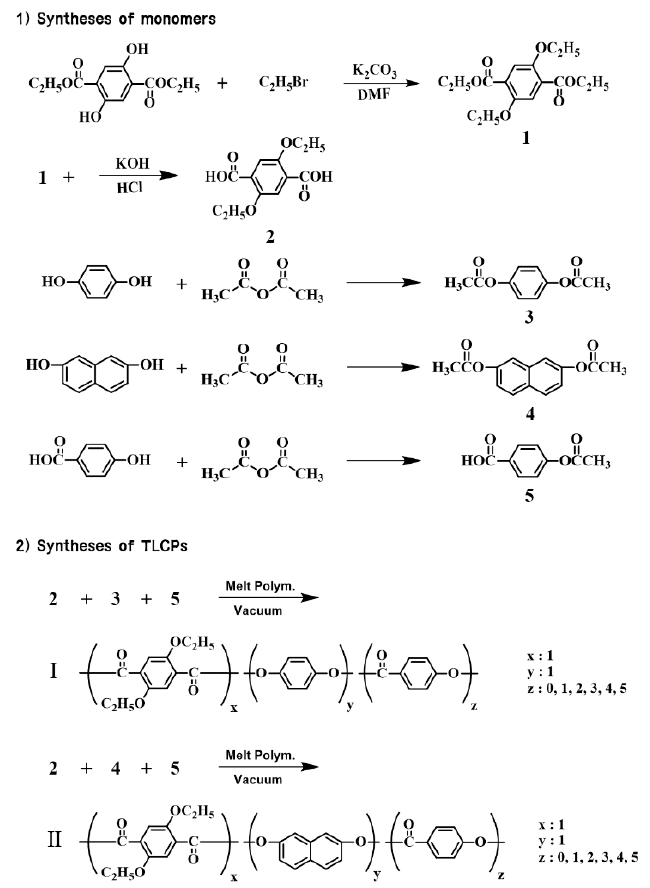
Figure 1. Synthetic routes of the thermotropic liquid crystalline polymers.